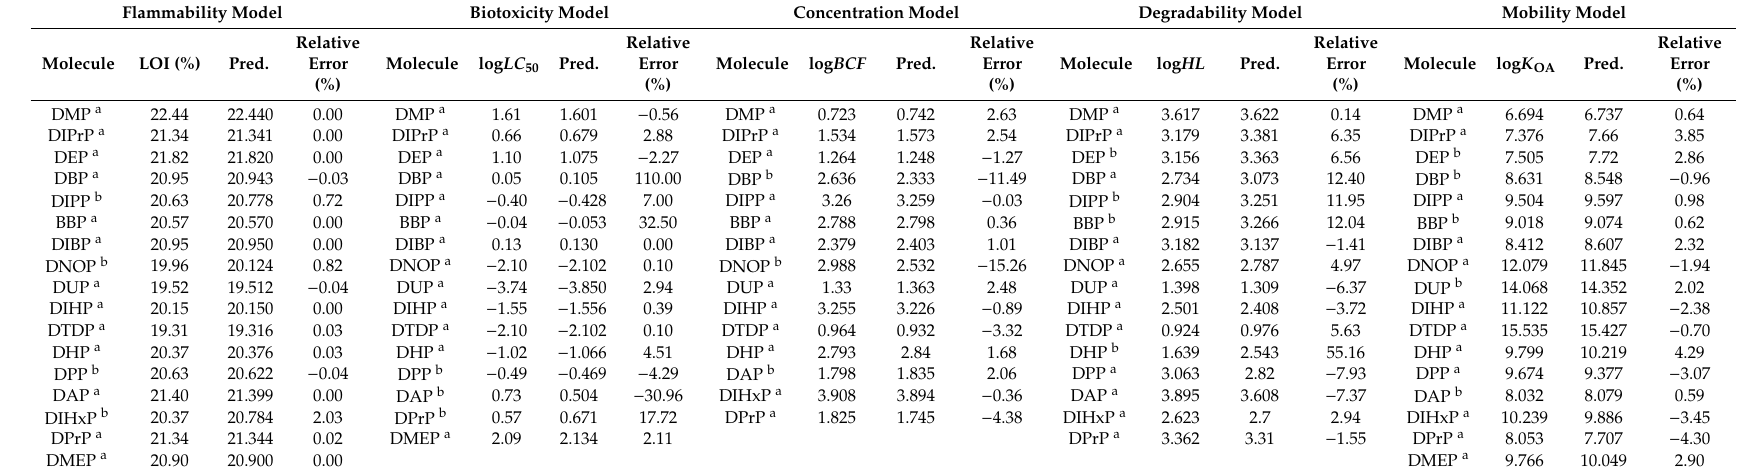
Table 6. The log LC 50 , log BCF , log HL , and log K OA values of the training sets and test sets in PAEs’ single-e ff ect models, and their Pred. and relative